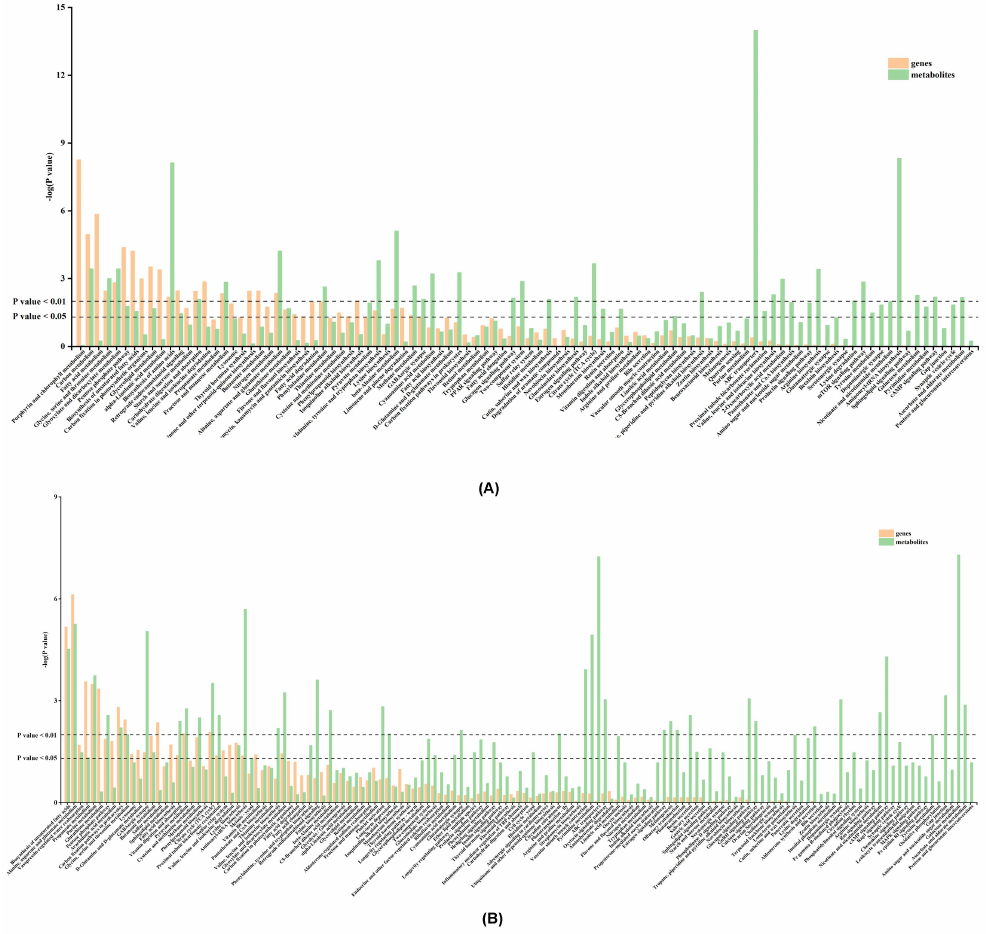
Figure 10. KEGG Pathway co-enriched analysis of DEGs and metabolites in ginseng leaves ( A ) and ginseng stems ( B ). Bar chart showing the number of genes/metabolites covered by each enriched pathway. The Y-axis indicates -Log 10 ( p -value) of genes/metabolites while the X-axis indicates the pathway name. yellow: gene; green: metabolites.